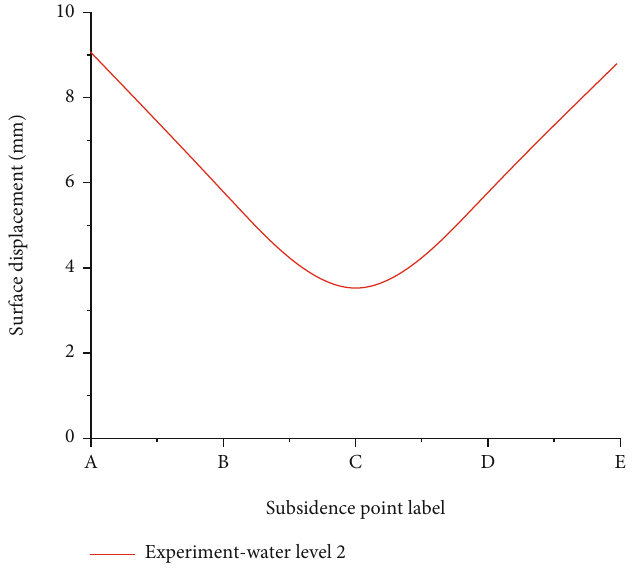
Figure 8: Surface displacement change map. Table 2: Parameters of concrete plastic damage